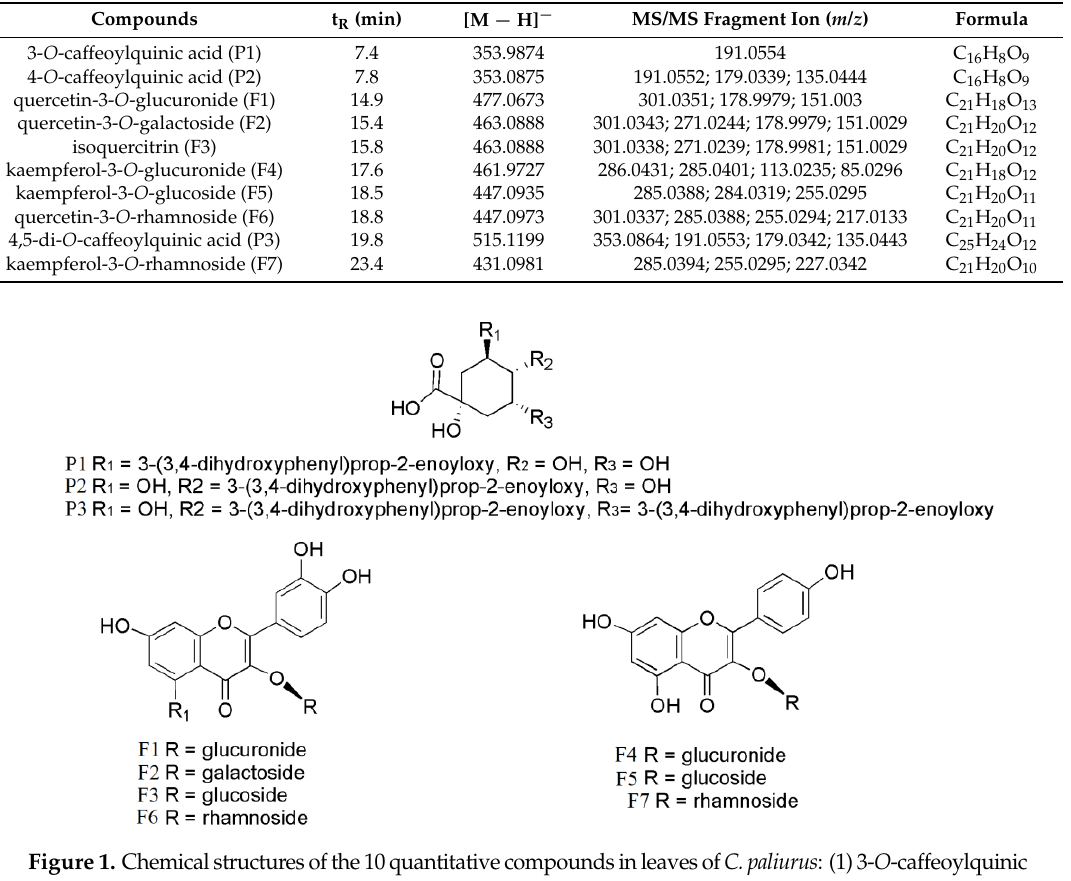
Table 1. The data of retention time, and MS and MS 2 fragment ions of 10 phenolics from leaves of C. paliurus by developed high-performance liquid chromatography coupled with quadrupole time-of-flight mass spectrometry (HPLC–Q–TOF–MS).